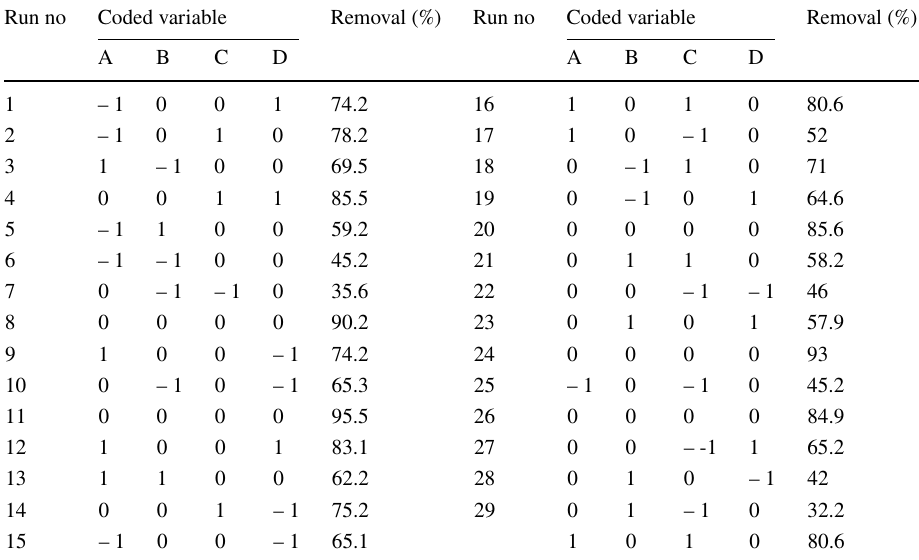
Table 2 BBD matrix for MG removal by S. platensis